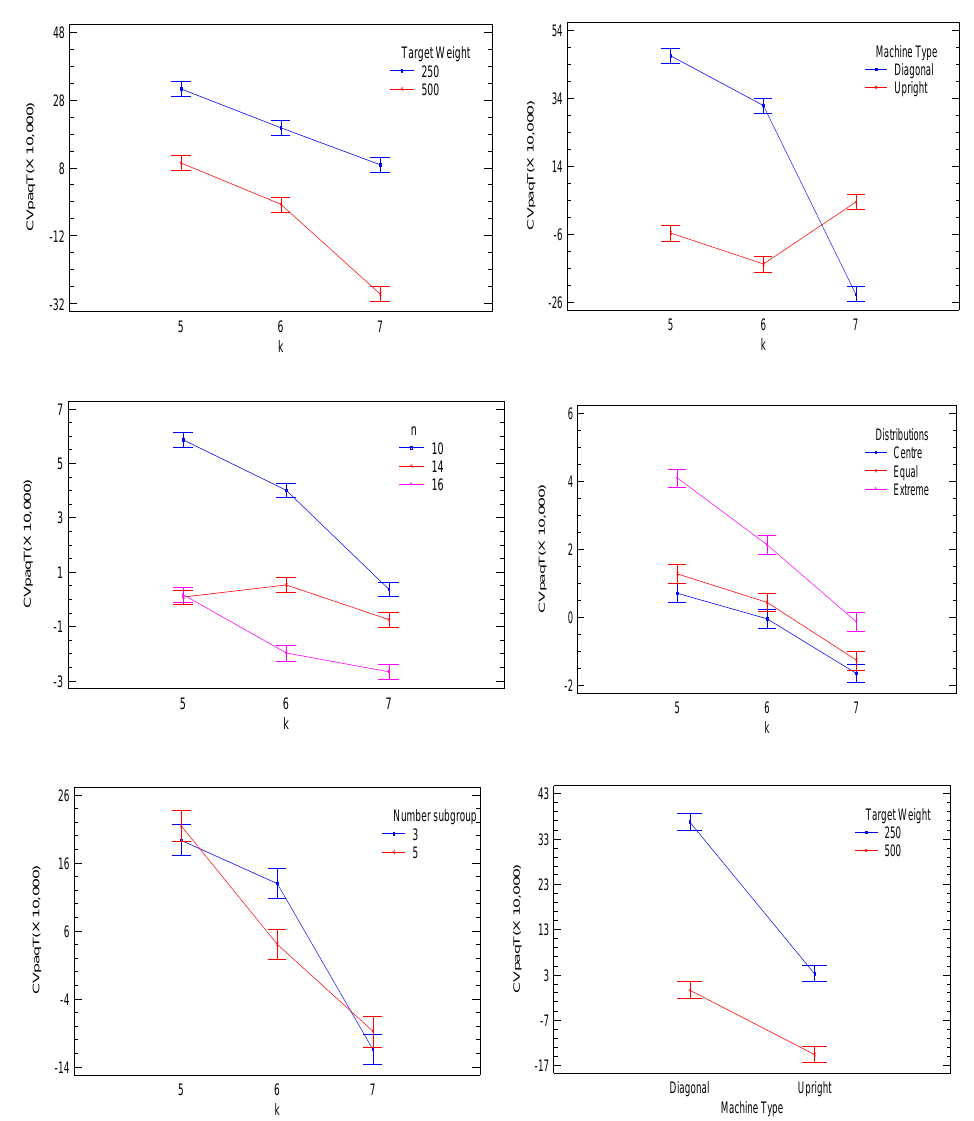
Figure 8. Significant interactions between factors for the CVpaqT (II) variable.